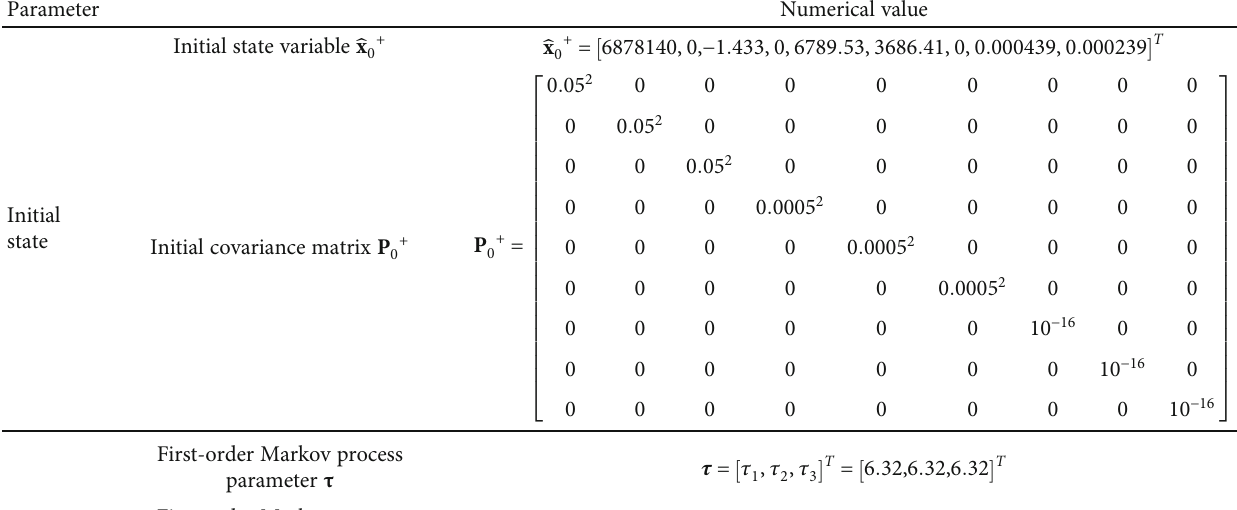
Table 1: Simulation parameter setting under 500 μ N